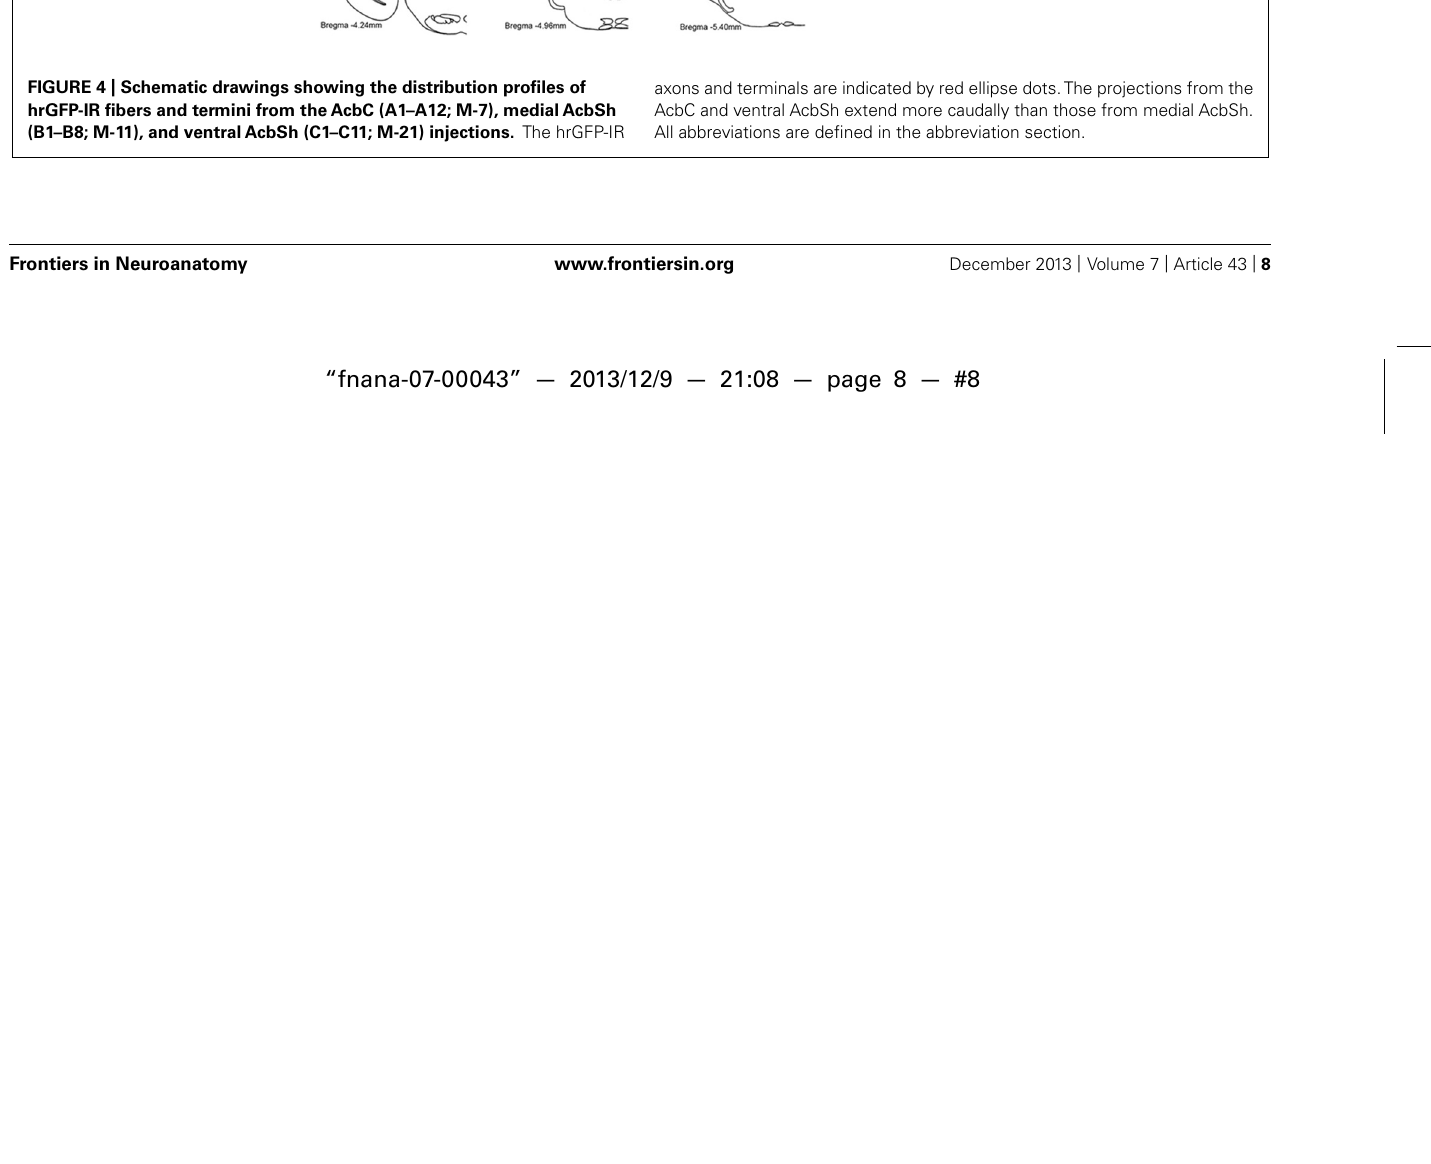
FIGURE 4 | Schematic drawings showing the distribution profiles of hrGFP-IR fibers and termini from theAcbC (A1–A12; M-7), medialAcbSh (B1–B8; M-11), and ventralAcbSh (C1–C11; M-21) injections. The hrGFP-IR